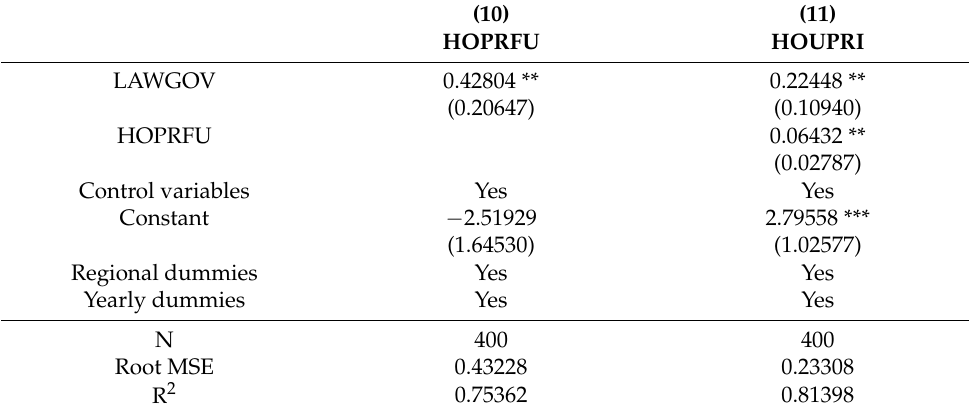
Table 7. Robustness test of the mediating role of financial